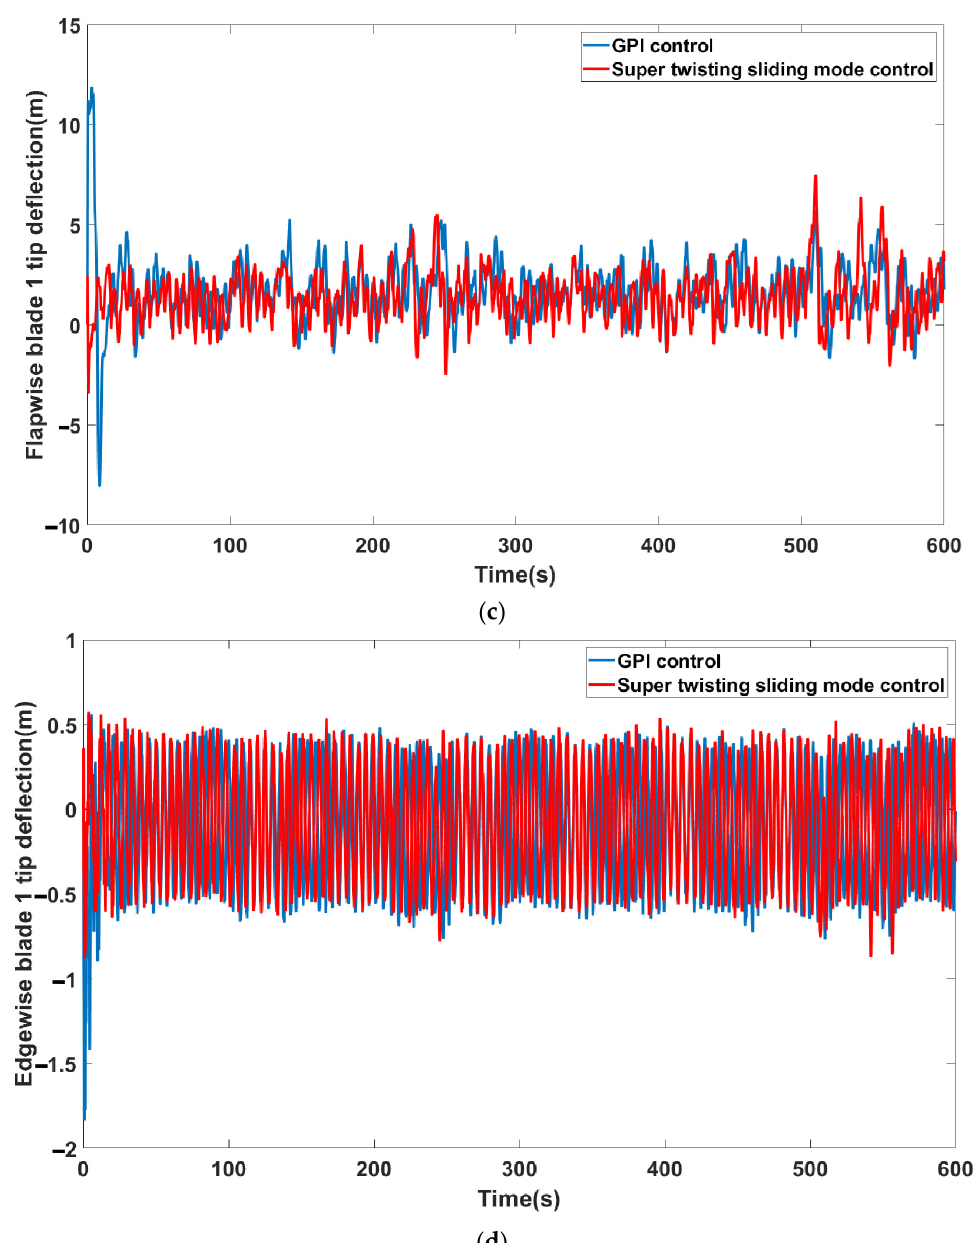
Figure 17. Comparison between the performance of the classical GPI control and Super twisting sliding mode control for ( a ) Rotor speed, ( b ) pitch angle, ( c ) Fdgewise blade 1 tip deflection, and ( d ) Edgewise tip deflection of blade 1.